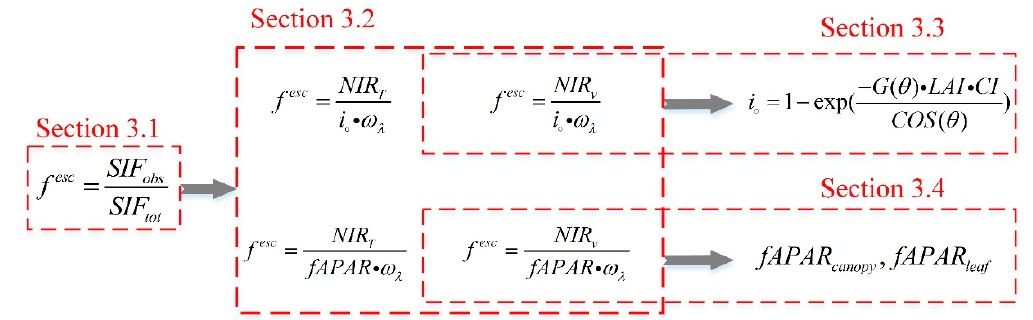
Figure 1. Flowchart of the evaluation process of SIF escape probability.